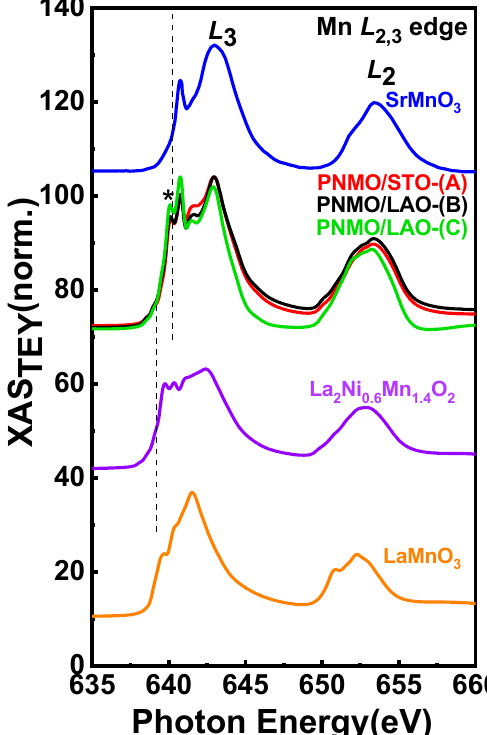
Figure 6. XAS spectra across the Mn L 2,3 edges for PNMO/STO-(A), PNMO/LAO-(B), and PNMO/LAO-(C) samples. LaMnO 3 , La 2 Ni 0.6 Mn 1.4 O 6 and SrMnO 3 XAS are shown for comparison.